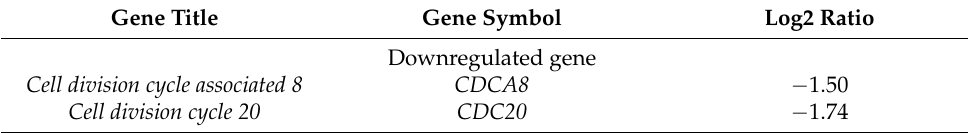
cell line. The red frame indicated the genes involve in the p53 signaling pathway. ( C ) GO enrichment classification map of genes regulated by ESD. The red frame indicated the genes involve in cell growth. Table 1. Fold change in genes downregulated by p53. Table 1. Fold change in genes downregulated by p53.